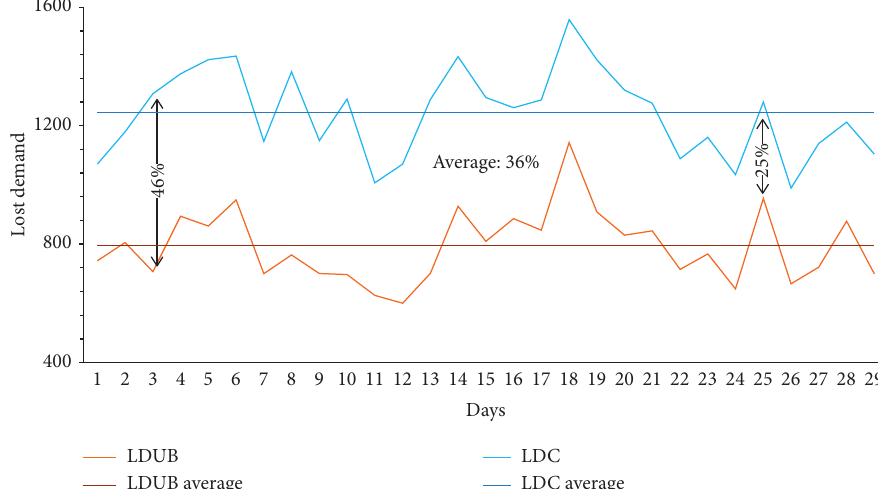
Figure 2: Difference in lost demand assessment between LDUB and LDC calculation